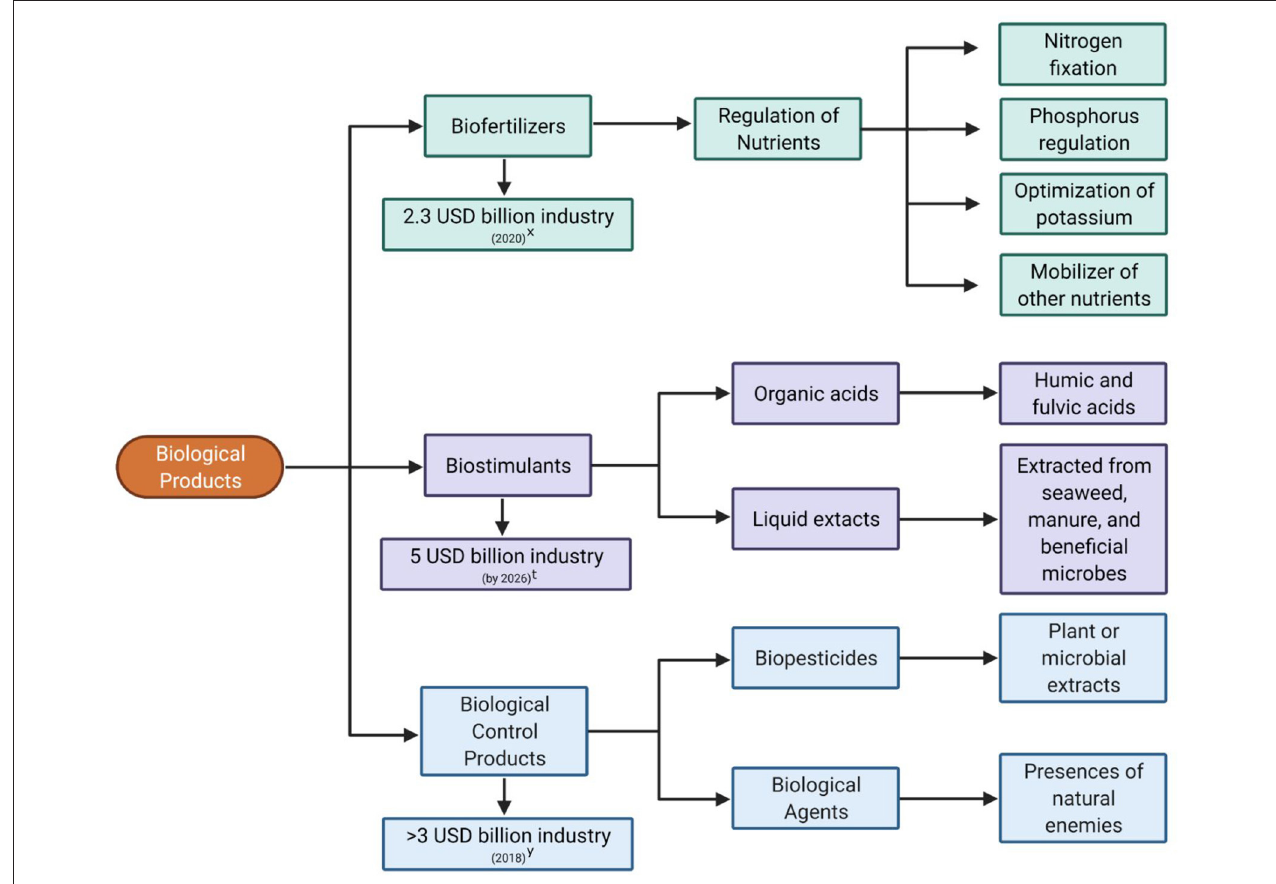
FIGURE 1 | Summary of the various types of biological products and their market value. (x) https://markets.businessinsider.com/news/stocks/biofertilizers-market- worth-3-9-billion-by-2025-exclusive-report-by-marketsandmarkets-1029369497; (t) http://www.globenewswire.com/en/news-release/2020/12/22/2149738/0/en/ Biostimulants-Market-revenue-worth-5-billion-by-2026-Says-GMI.html; (y)